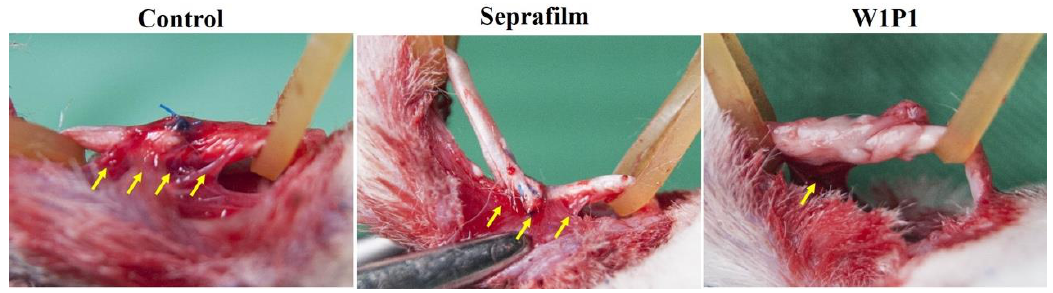
Figure 6. Gross observations of the repaired flexor digitorum profundus tendons in different groups: The yellow arrows indicate the sites of scar adhesion. Severe adhesion and scarring were noted in the surgical control group. For the tendons wrapped with Seprafilm, the adhesion was less severe compared with the surgical controls. The W1P1 NFM group exhibited the least adhesion and scarring around the repaired tendon.